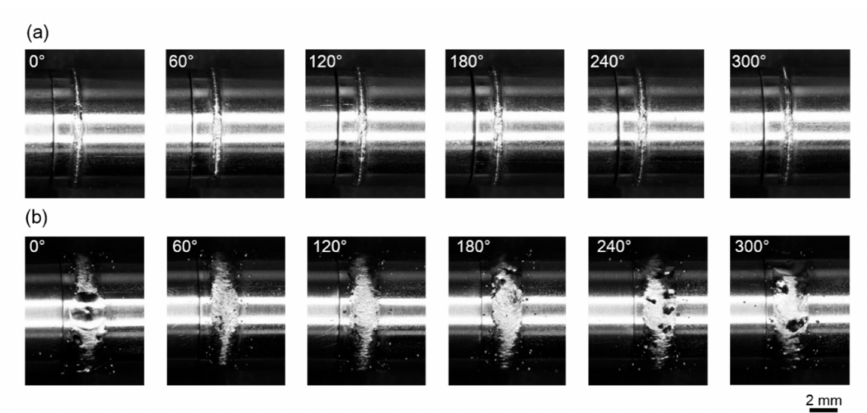
Figure 5. The morphology of the welded seams of the laser-welded NS Mo alloy joints with: ( a ) heat input of 250 J / cm; ( b ) 3600 J /